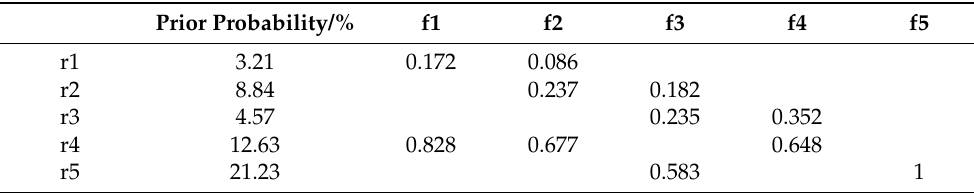
Table 7. Conditional probability table of CB4.